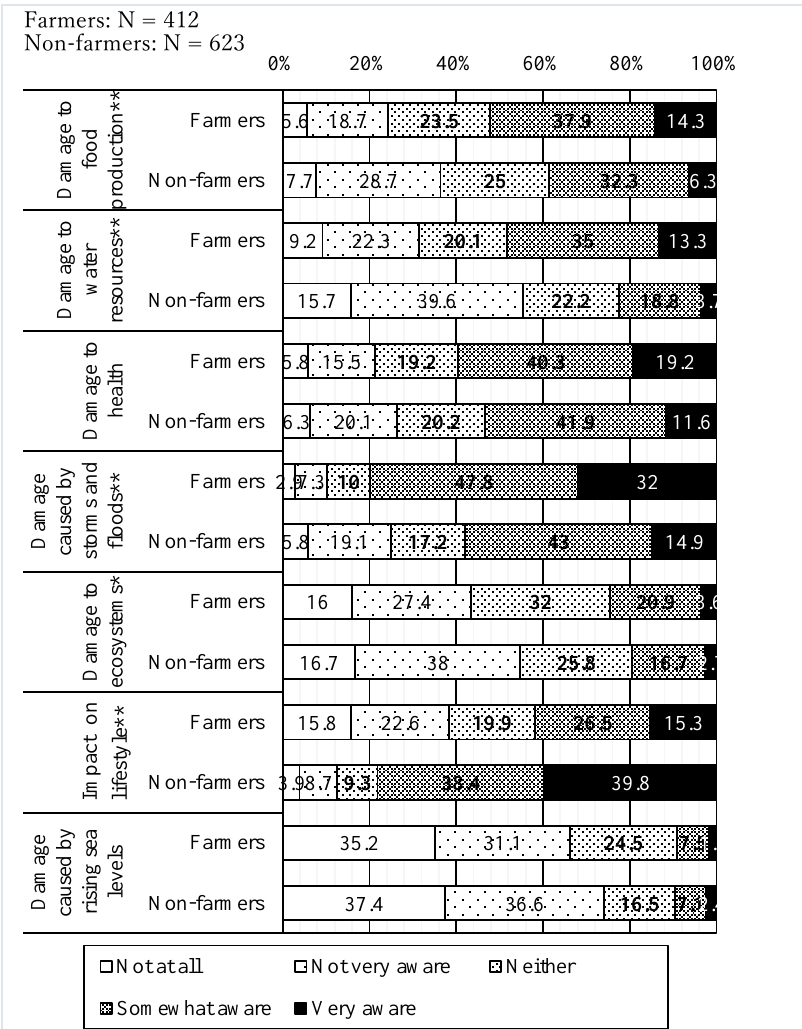
Figure 1. Perception of climate change risks